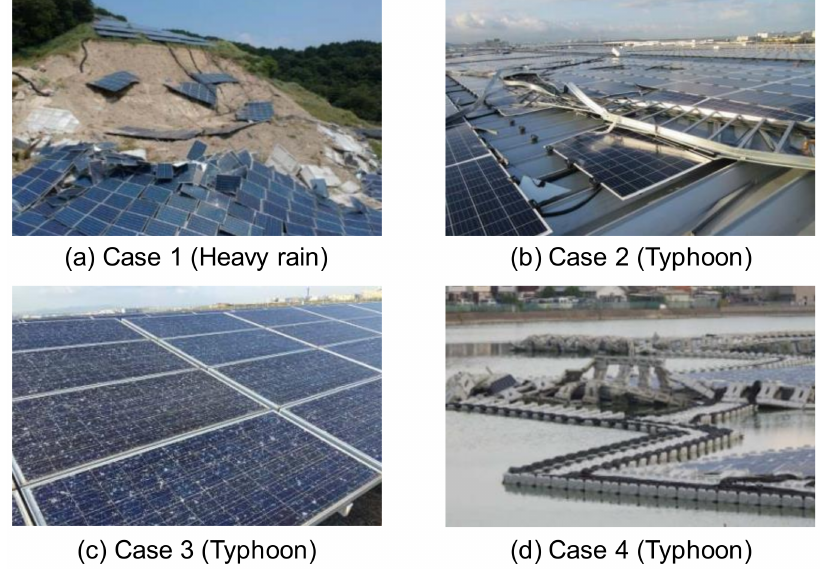
Figure 9. PV solar plant damage caused by natural events